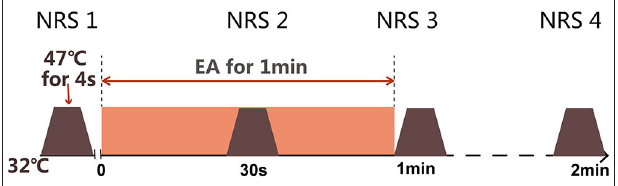
FIGURE 3 | Measurement of dynamic QST (CPM NRS). Numerical rating scale (NRS) scores are obtained under heat stimulus of 47 ◦ C at SP6 for 4s before electroacupuncture (EA), during EA, immediately after EA, and 1min after EA.